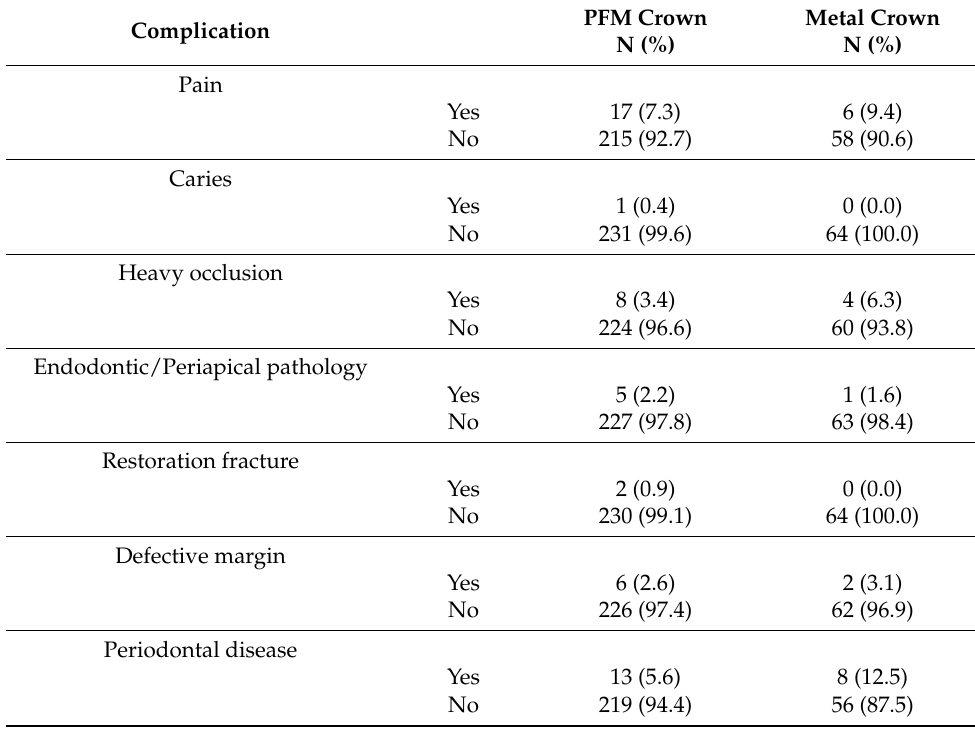
Table 3. Complications associated with PFM and metal crowns (N =